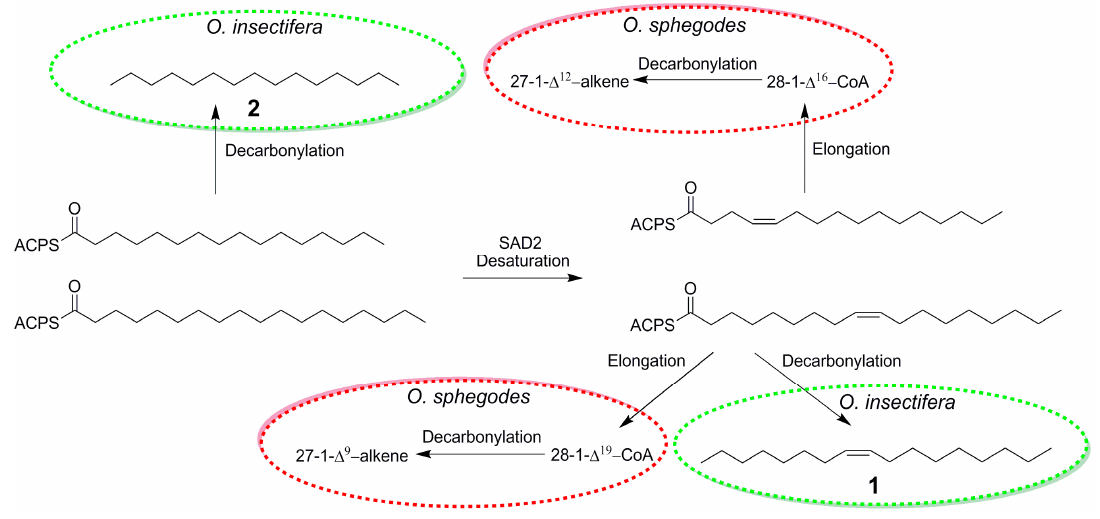
Figure 2. Proposed biosynthesis of bioactive alkenes in Ophrys sphegodes (from [32]) and O. insectifera.